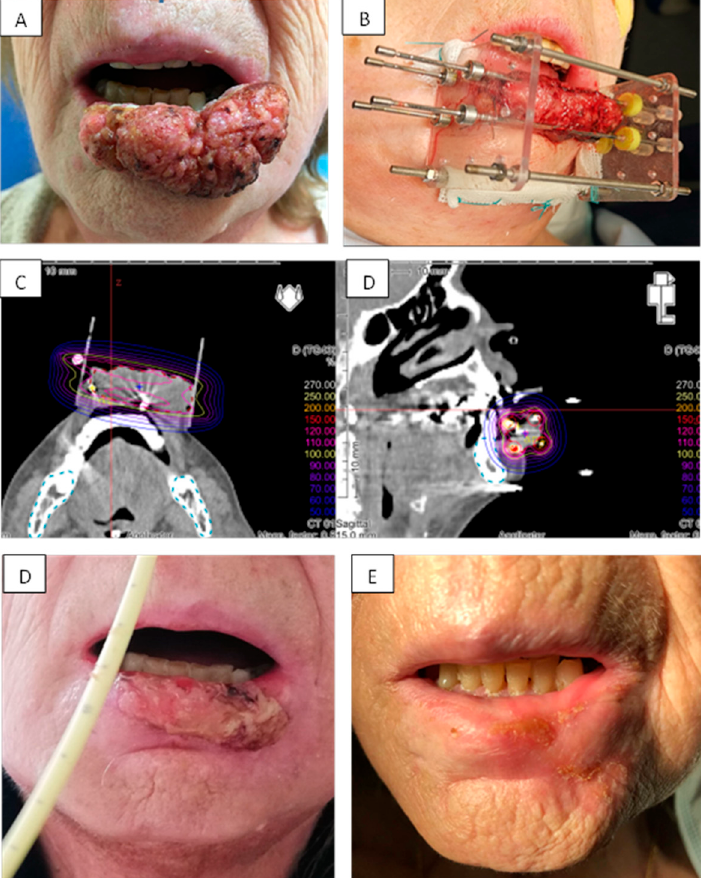
Figure 2. Example of brachytherapy implantation for a T3 N0 squamous cell carcinoma of the inferior lip. Tumor was measured at 60 mm and localized in the inferior lip ( A ). Implantation was done following Paris system rules with two planes arranged in squares with 15 mm spacing. Four needles were used ( B ). The dose distribution was optimal, with high dose to the tumor (>70 Gy) while minimizing dose to the bone ( C ). Patient experienced acute reaction with radiomucitis grade II at week 8 ( D ). At one year, complete response was achieved with disappearance of all acute reactions and persistence of a small fibrotic scare ( E ).